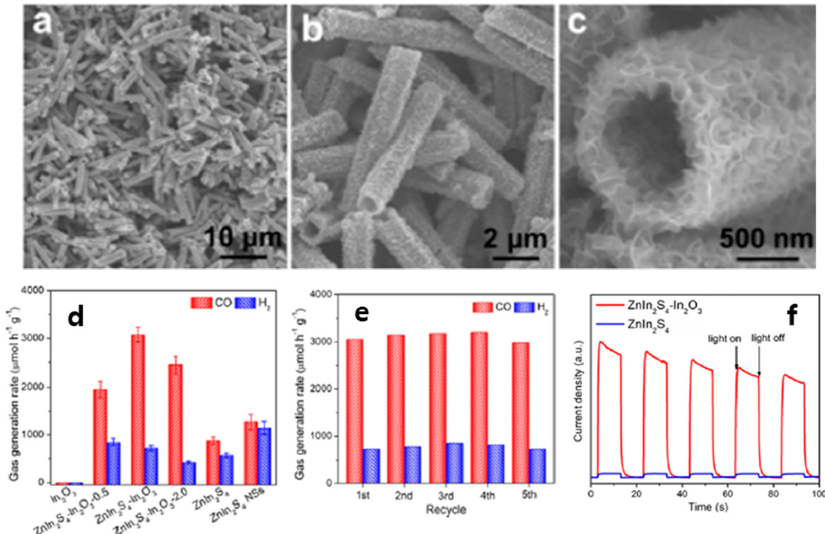
Figure 13. ( a − c ) FESEM images of ZnIn 2 S 4 − In 2 O 3 , ( d ) Photocatalytic CO 2 reduction activities of Figure 13. (a − c) FESEM images of ZnIn 2 S 4 − In 2 O 3 , (d) Photocatalytic CO 2 reduction activities of di ff erent samples, ( e ) Stability test and ( f ) Transient photocurrent spectra of hierarchical ZnIn 2 S 4 − In 2 O 3 different samples, (e) Stability test and (f) Transient photocurrent spectra of hierarchical ZnIn 2 S 4 − In 2 O 3 and ZnIn 2 S 4 samples, reprinted with permission from [107]. and ZnIn 2 S 4 samples, reprinted with permission from [107].